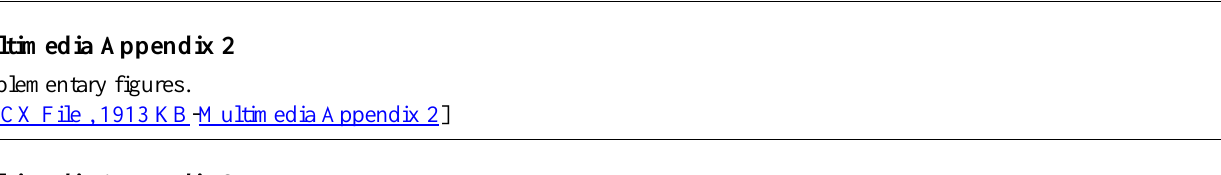
Supplementary Table 1: Final XGBoost, LASSO and logistic regression model hyperparameters.